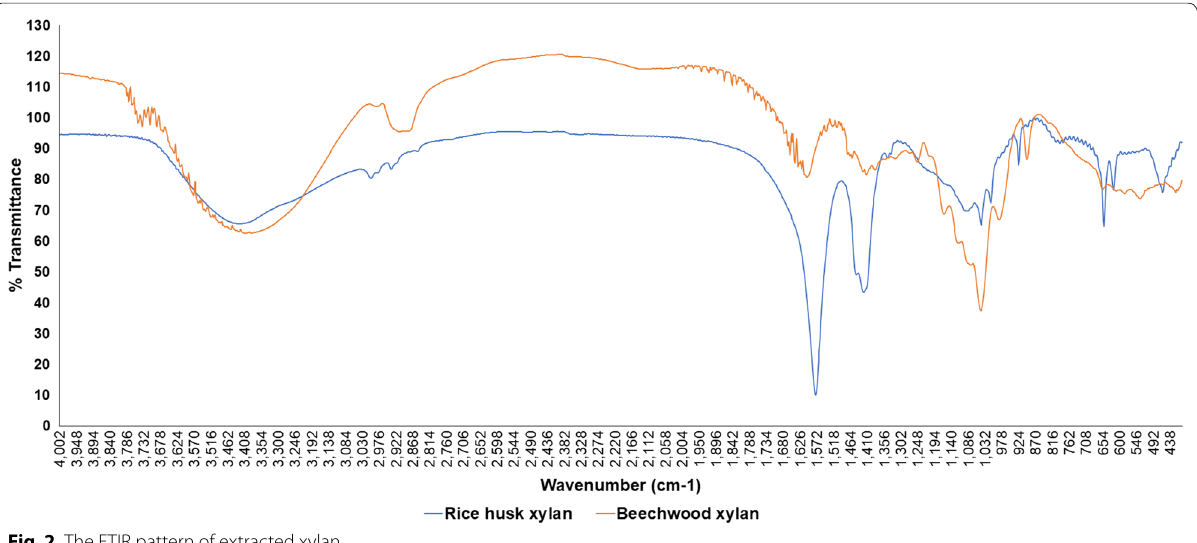
Fig. 2 The FTIR pattern of extracted